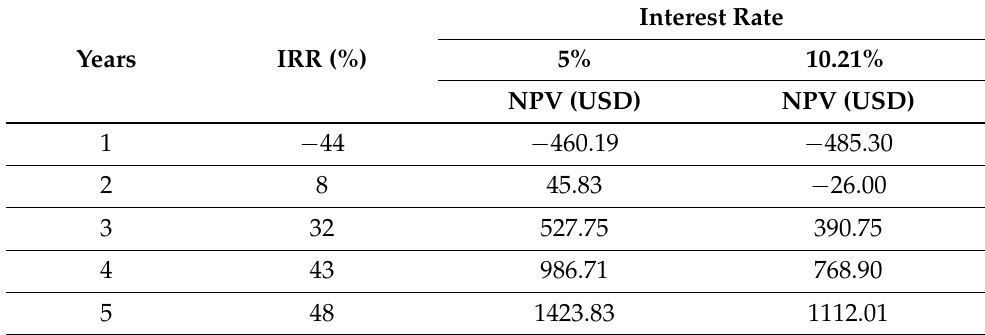
Table 5. Sensitivity analysis of third